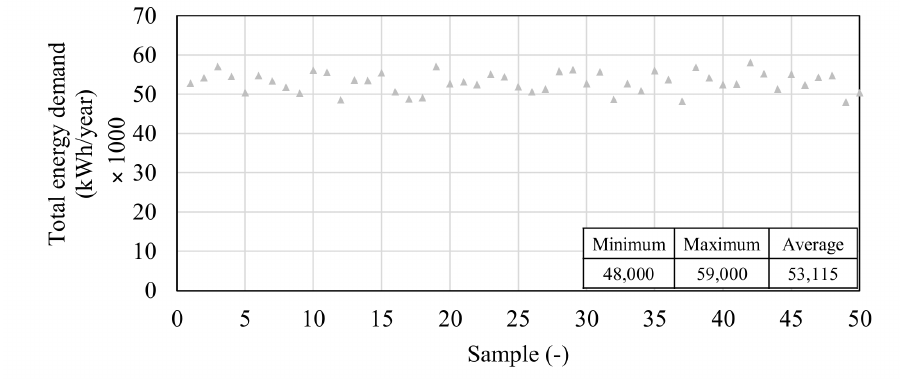
Figure 9. Results of the energy simulation for Model Id.